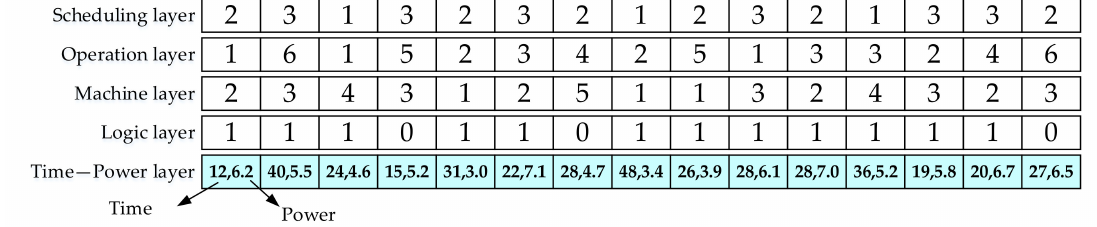
Figure 6. An encoding sample for a solution to the multi-objective